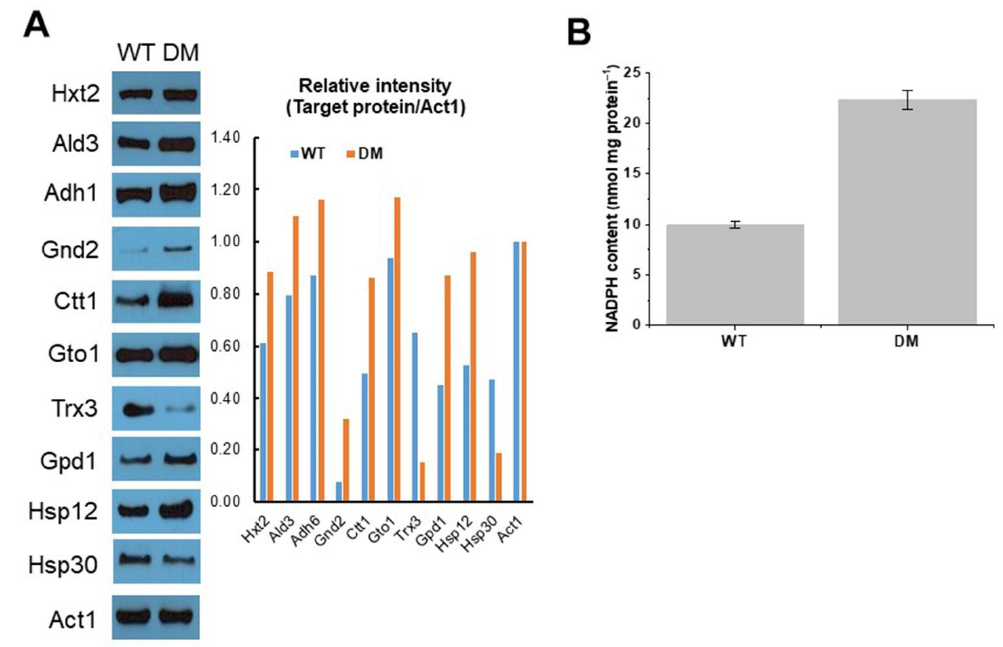
Figure 7. Expression analysis at the protein level of 2-fold changed genes (left panel) and signal intensity (right panel) ( A ) and NADPH assay ( B ). Signal intensity was calculated using Image J. Evaluation of intracellular NADPH was assayed by spectrophotometric quantification. Data were analyzed using Origin 2020. The data are the means and standard deviations of three independent experiments with at least two biological replicates each. A probability analysis to determine statistical significance was performed using the Student’s t -test. Compared to the appropriate control strain, p <0.05 was considered significant in this study. Hxt2, hexokinase 2; Ald3, aldehyde dehydrogenase isoform 3; Adh6, alcohol dehydrogenase isoform 6; Gnd2, 6-phosphogluconate dehydrogenase; Ctt1, cytosolic catalase; Gto1, glutathione-S-transferase isoform 1; Trx3, Mt thioredoxin; Gpd1, glyceraldehyde-3-phosphate dehydrogenase; Hsp12, heat shock protein 12; Hsp30, heat shock protein 30; Act1, actin isoform 1 was used as loading control; WT, wild-type cells with empty vector; DM, DaMDHAR - expressing transgenic cells.